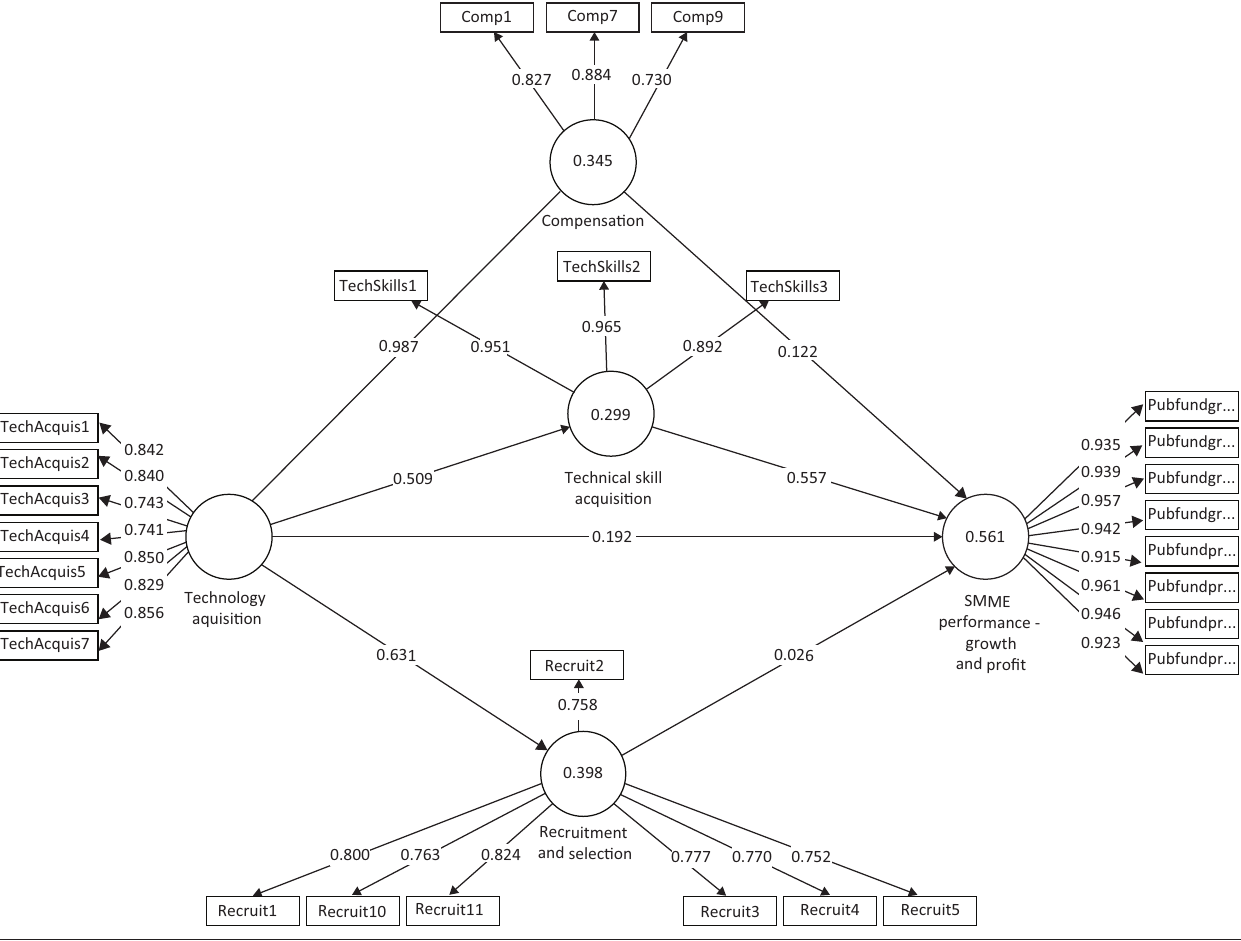
FIGURE 2: The results of the structural model.